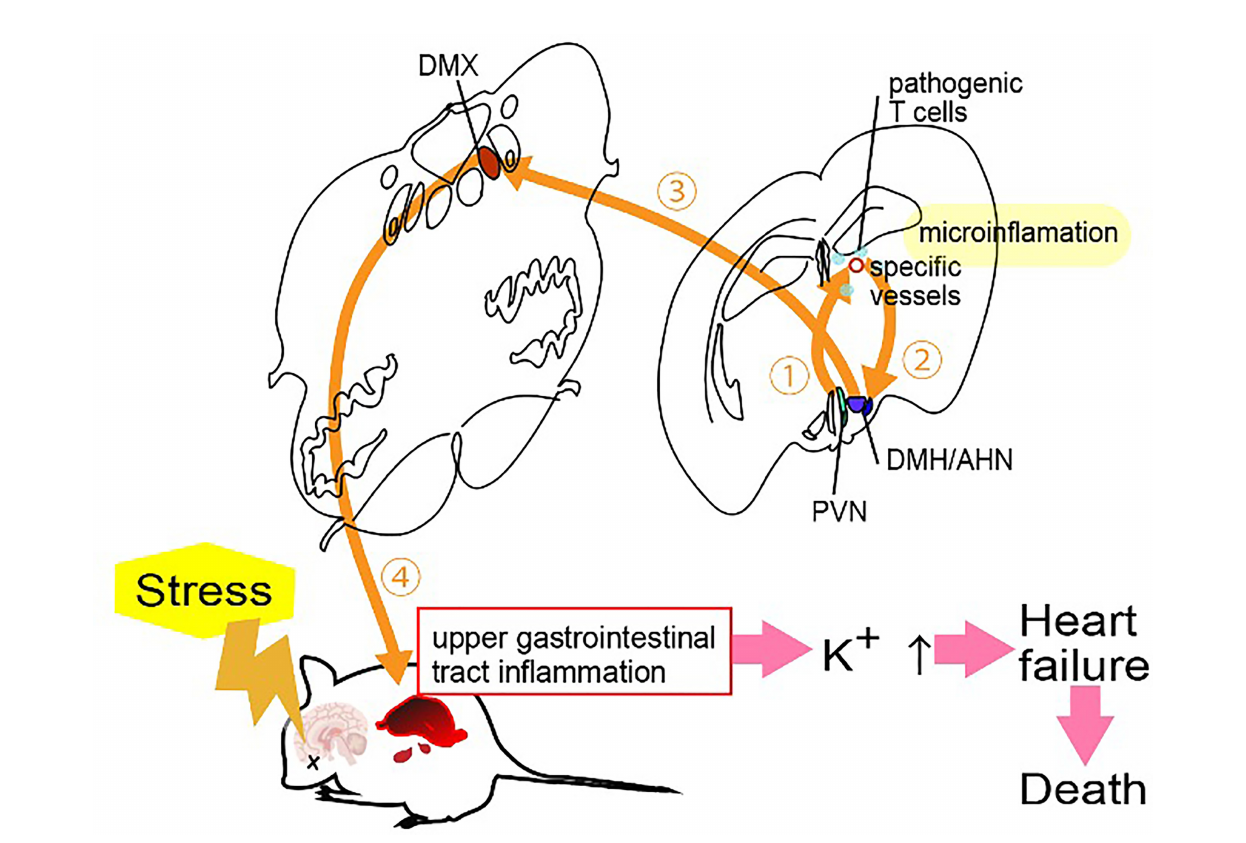
FIGURE 4 | Pain gateway re fl ex. Pain-induced sensory nerve activation stimulates the anterior cingulate cortex (ACC), which activates speci fi c sympathetic nerves distributed at two ventral vessels of the spinal cord. Because there are many major histocompatibility complex (MHC) class II + monocytes around the L5 cord, norepinephrine secretion at the ventral blood vessels of the fi fth lumbar vertebra (L5) cord stimulates the production of CX3CL1 from endothelial cells via the IL-6 ampli fi er. CX3CL1 accumulates MHC class II + monocytes and increases the permeability of blood vessels. Autoreactive T cells in the blood fl ow accumulate at the vessels to induce experimental autoimmune encephalomyelitis